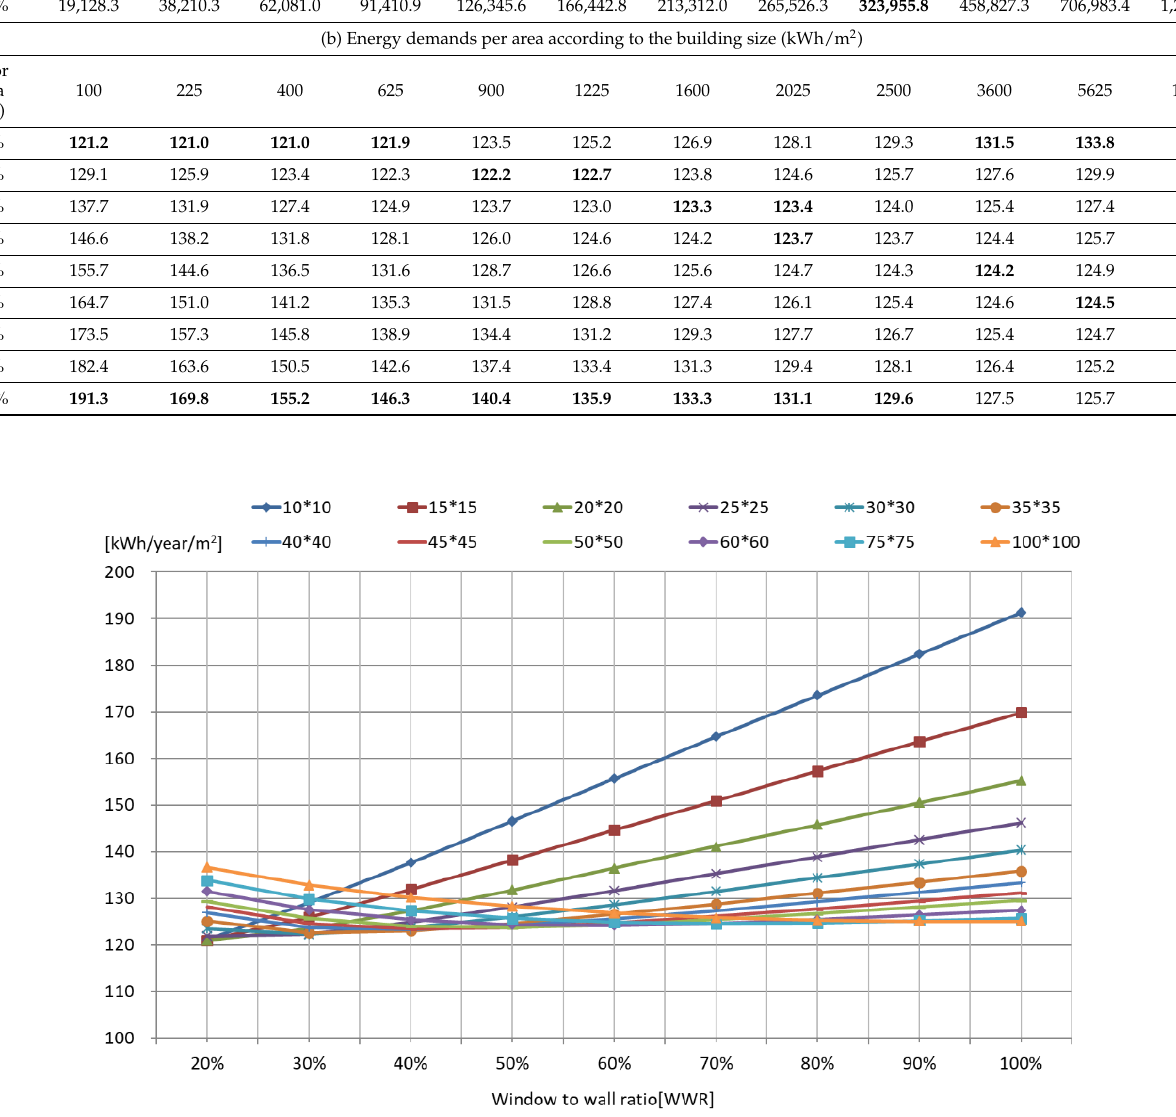
Figure 2. Energy demand per area according to the WWR by building size.